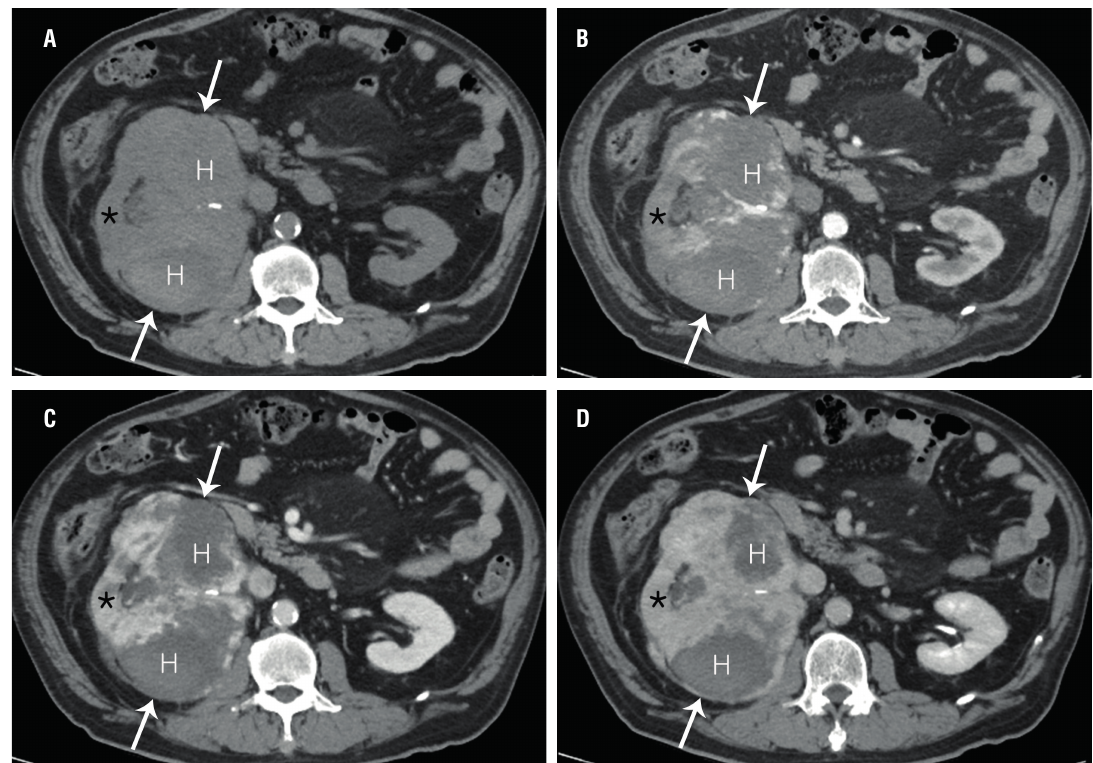
Figure 1 - Axial CT images of pre-contrast (A), contrast-enhanced corticomedullary (B), nephrographic (C) and excretory (D) phases depict a huge mass (arrows) with extensive hemorrhage (H) in the right kidney, which shows progressive peripheral nodular enhancement with a delayed fill-in. Note the presence of residual renal parenchyma